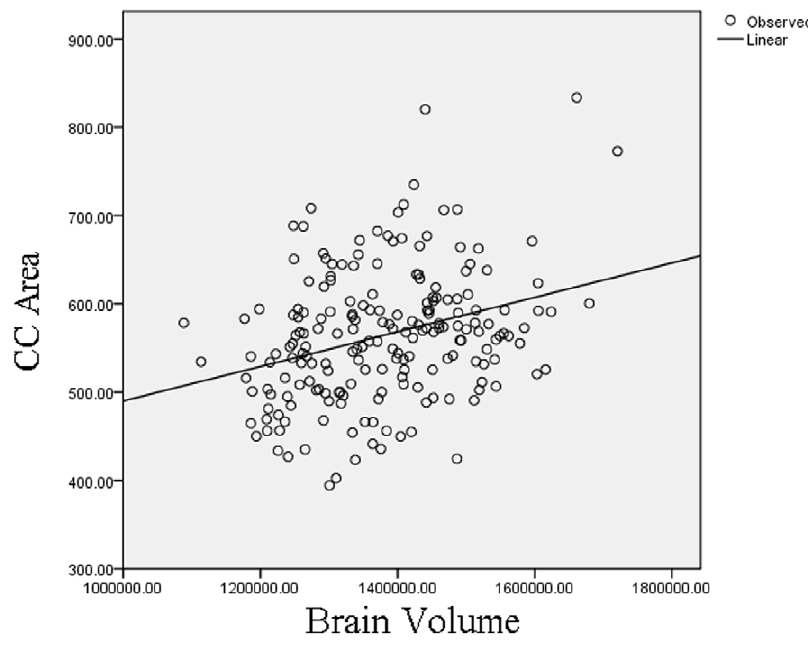
Figure 2. Regression of total corpus callosum area against total brain volume.